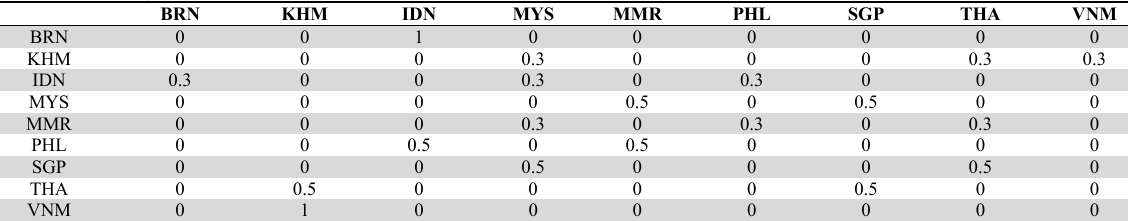
Customized weighted matrix